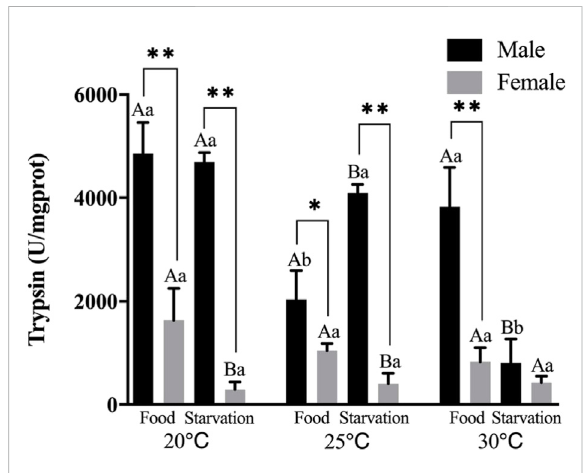
FIGURE 5 Trypsin (PS) of different sex M. coruscus exposed to six combinations of temperature (20, 25, and 30 ° C) and the feeding condition (food and starvation) at 30 days during the exposure period.Differentcapitallettersindicatesigni fi cantdifferences between the feeding condition and each temperature levels (20, 25, and 30 ° C) ( p < 0.05). Different small letters indicate signi fi cant differences between temperature (20, 25, and 30 ° C) and the same feeding condition ( p < 0.05). Asterisk indicates signi fi cant differences between sex and each feeding condition, in which * representssigni fi cantdifference( p < 0.05)and**representshighly signi fi cant difference ( p <